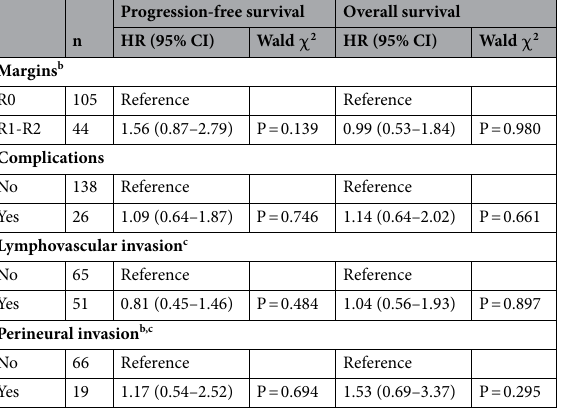
Table 3. Hazard ratio (HR) a and corresponding 95% confidence intervals (CI) of PFS event and death for surgical features. a Estimated through Cox proportional hazard model, adjusting for gender, age, cancer site, initial TNM stage, disease free interval, and recurrence site. b The sum does not add up to total because of missing values. c Patients with regional or loco-regional recurrence.